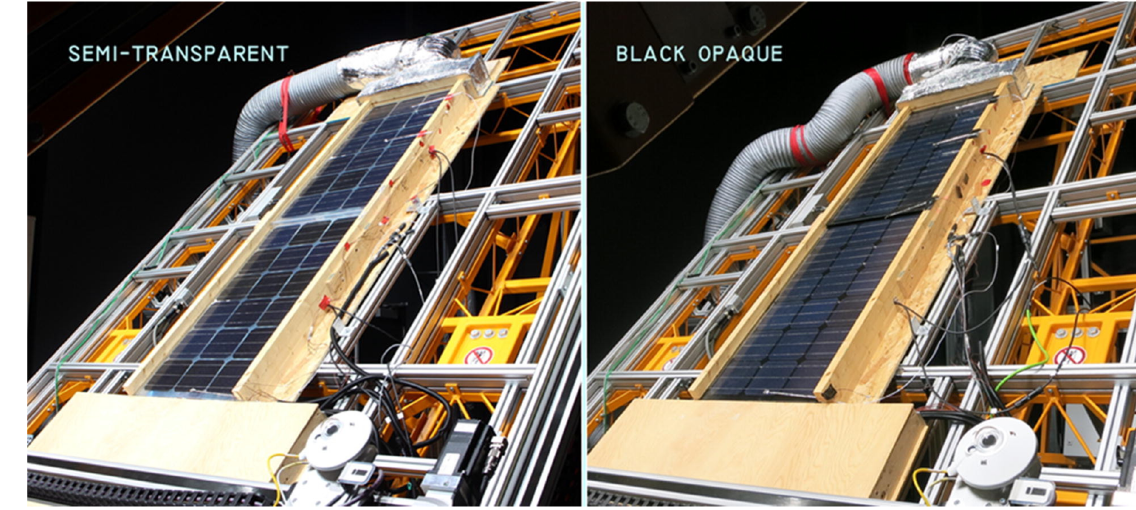
Figure 5. Real photos of BIPV system using semi-transparent and black opaque PV panels. Reproduced with permission from ref. [157]. Copyright 2014 Elsevier.